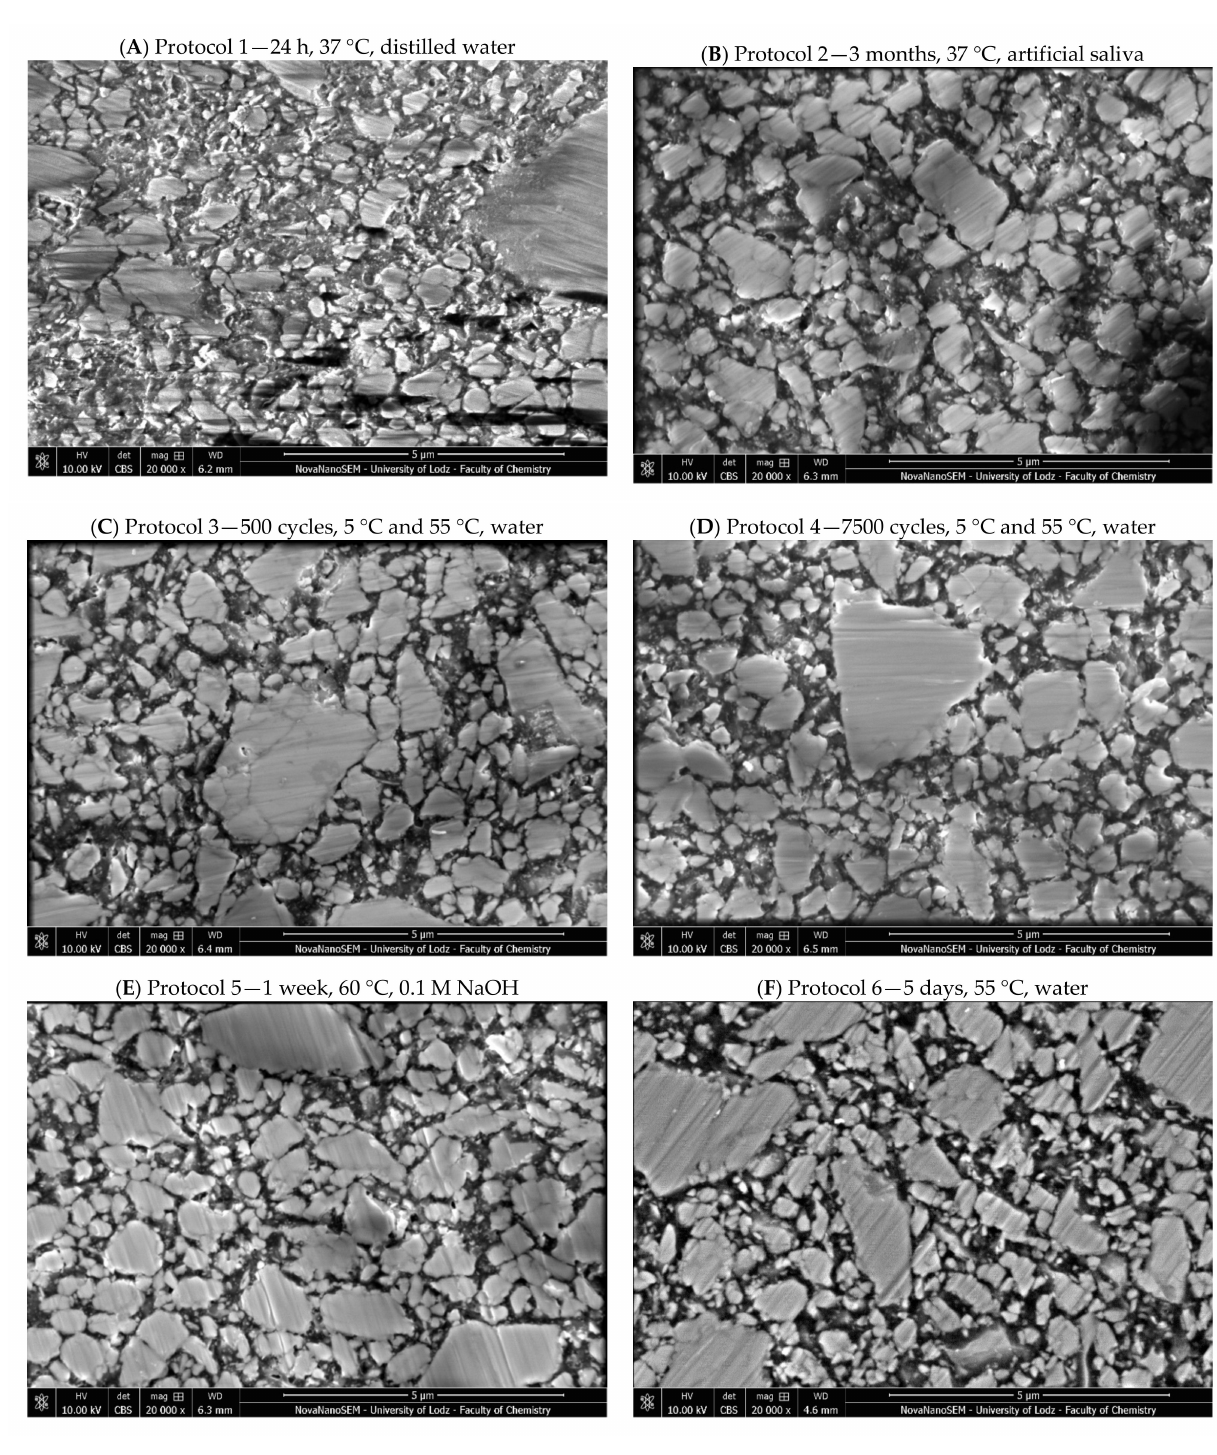
Figure A12. Scanning electron microscopy (SEM) micrograph of Arkon at 20,000 × magnification after six aging protocols: ( A ) Protocol 1—24 h, 37 ◦ C, distilled water, ( B ) Protocol 2—3 months, 37 ◦ C, artificial saliva, ( C ) Protocol 3—500 cycles, 5 ◦ C and 55 ◦ C, water, ( D ) Protocol 4—7500 cycles, 5 ◦ C and 55 ◦ C, water, ( E ) Protocol 5—1 week, 60 ◦ C, 0.1 M NaOH, ( F ) Protocol 6—5 days, 55 ◦ C,